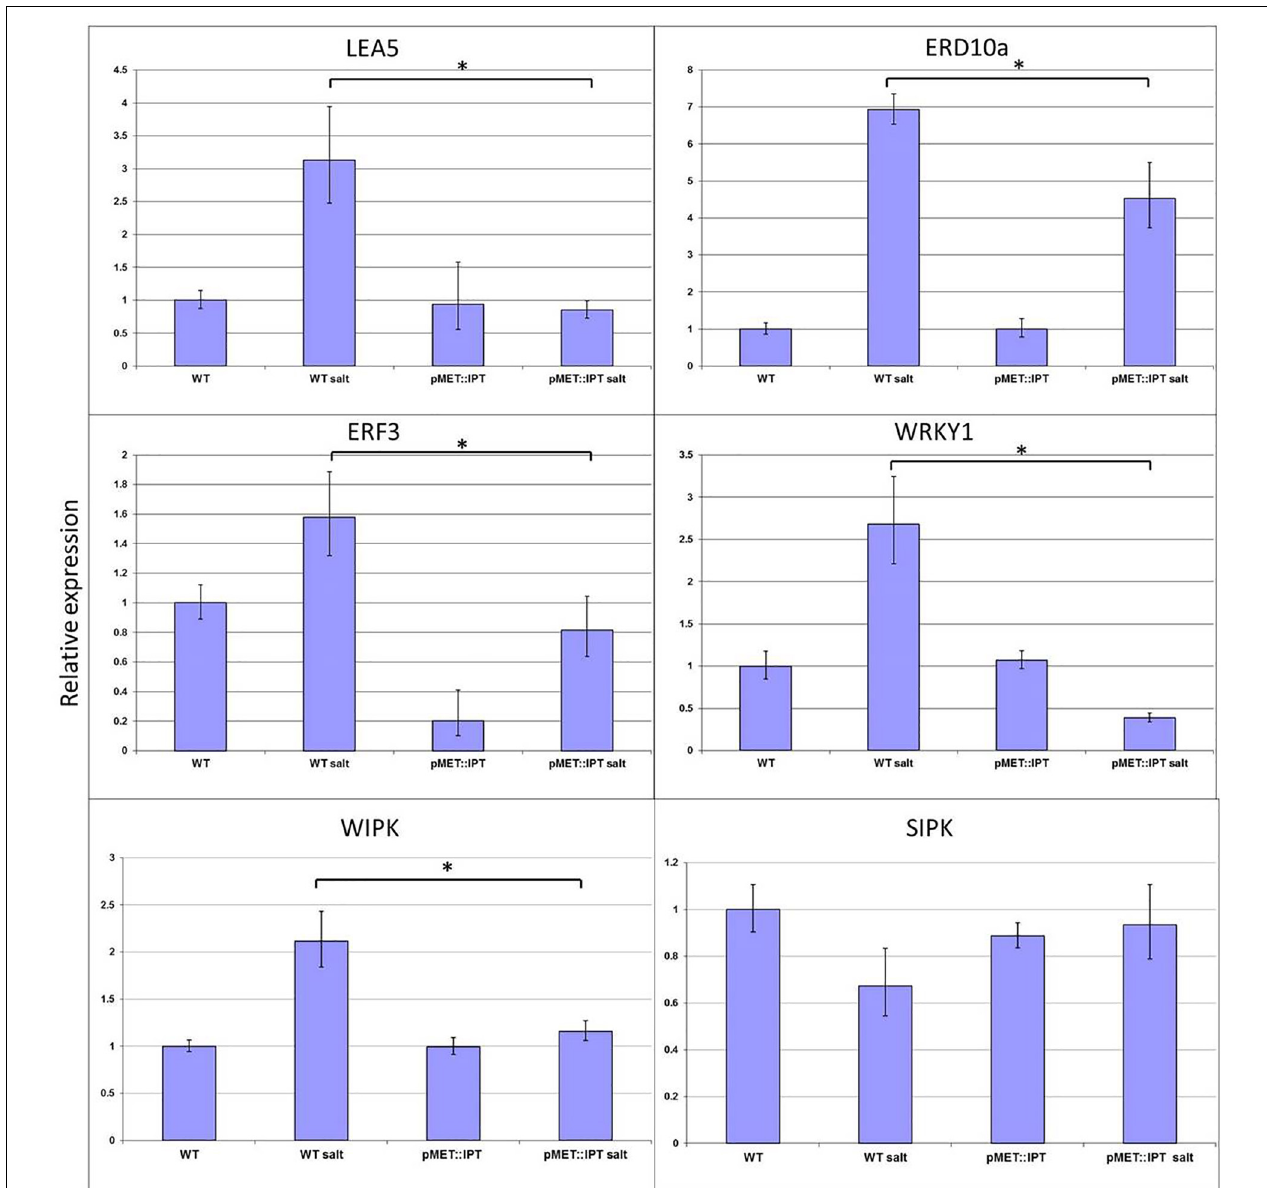
FIGURE 7 | Relative expression of LEA5 , ERD10a, ERF3, WRKY1 , WIPK, and SIPK genes in WT and pMT:IPT tobacco plants during salinity stress. Tobacco plants were grown under optimal conditions for 3 weeks and then were watered with NaCl solution (100 and then 200 mM) for three more weeks. Leaf samples were collected simultaneously from WT and pMT:IPT plants (in three independent replicates). Gene expression was determined by real-time PCR. Gene expression in the WT plants under control conditions serves as the reference. Asterisk refers to statistically significant difference between treatments ( p < 0.05). Values correspond to means ± SE of three independent